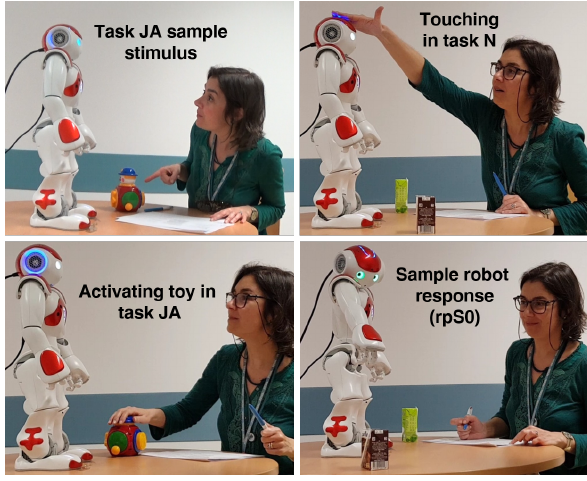
Figure 5: Autism therapist interacting with the robot and coding its responses according to the ADOS-2